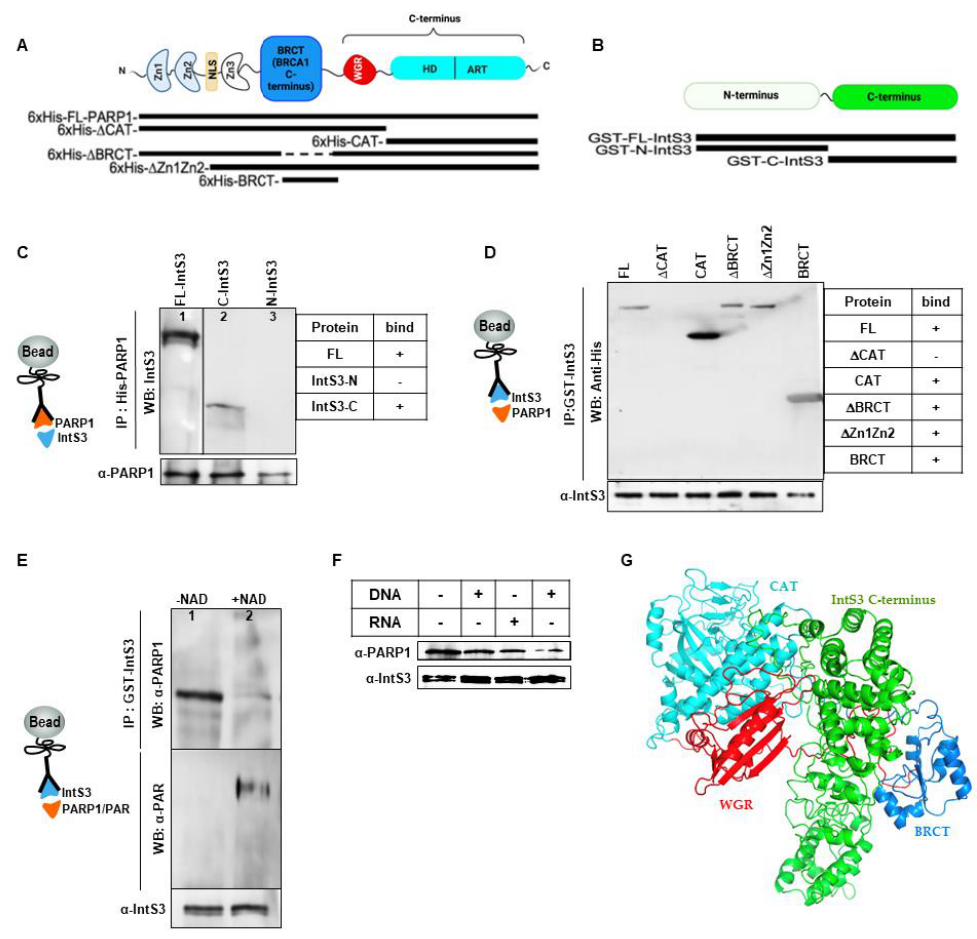
Figure 2. PARP1 and IntS3 form a stable complex in vitro. ( A ) Schematic presentation of PARP1 structural domains and types of PARP1 constructs used in the study. ( B ) IntS3 structural domains and types of proteins used in the study. ( C ) Pull-down of FL-His-PARP1 shows association with both GST-FL-IntS3 (Lane 1) and C-terminal containing IntS3 mutant (C-IntS3, Lane 2) but not IntS3 lacking the C-terminal (N-IntS3, Lane 3). PARP1 was pulled down with His antibody while Western blot analyses with anti-GST antibody show bound IntS3. Anti-PARP1 antibody was used to show the load of PARP1 on the beads. ( D ) GST-tagged FL-IntS3 was incubated with different constructs of PARP1 (His-FL-PARP1, Lane 1), deletion of the catalytic domain ( CAT, Lane 2), catalytic domain (CAT, Lane 3), deletion of the BRCT domain mutant ( BRCT, Lane 4), deletion of the Z1 and Z2 domains mutant ( Z1 Z2, Lane 5), and the BRCT-domain-only containing mutant BRCT (Lane 6). Association between IntS3 and these mutants is shown via Western blot analysis with anti-His antibody. Additionally, anti-IntS3 antibody is used to show load of IntS3. ( E ) PARylation of PARP1 does not impact the association of PARP1 and IntS3. PARP1 was incubated without NAD+ (Lane 1) and with NAD+ (Lane 2) to PARylate PARP1. PARylation did not disrupt PARP1-IntS3 binding. ( F ) PARP1-IntS3 binding does not depend on DNA or RNA presence. ( G ) Alphafold [43] prediction of C-terminal of PARP1 binding (BRCT to ART) to C-terminal domain of InSt3.